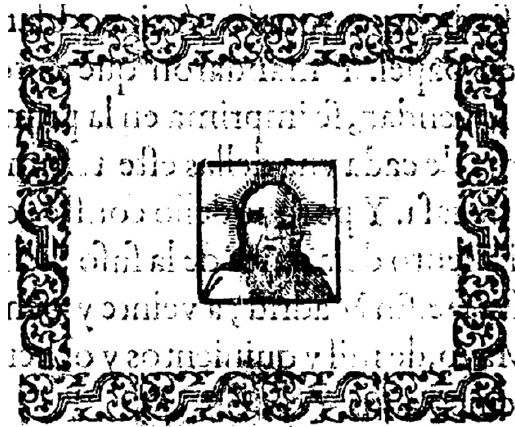
Figure 7. Anonymous. Rostro de Dios . Book cover of Francisco de Castro: Historia de la vida y sanctas obras de Iuan de Dios … En Granada en casa de Rene Rabut. Año de 1588.